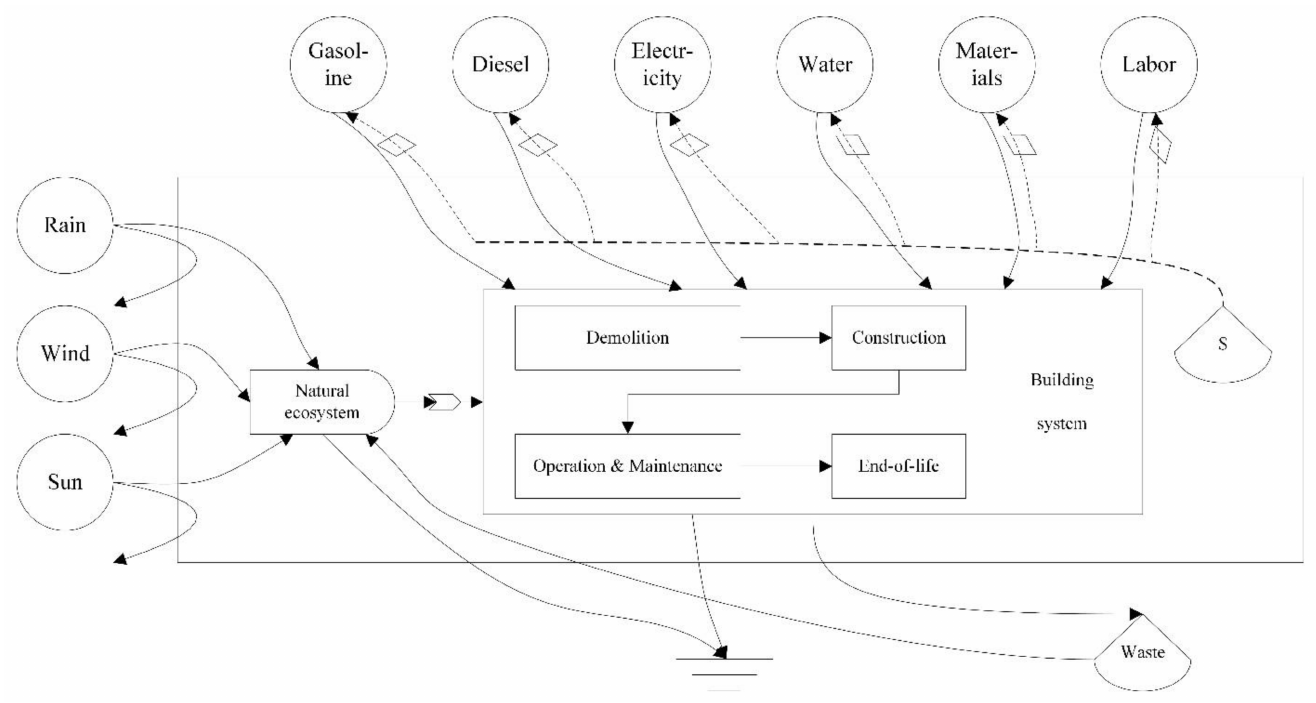
Figure 2. Emergy diagram of the material and energy